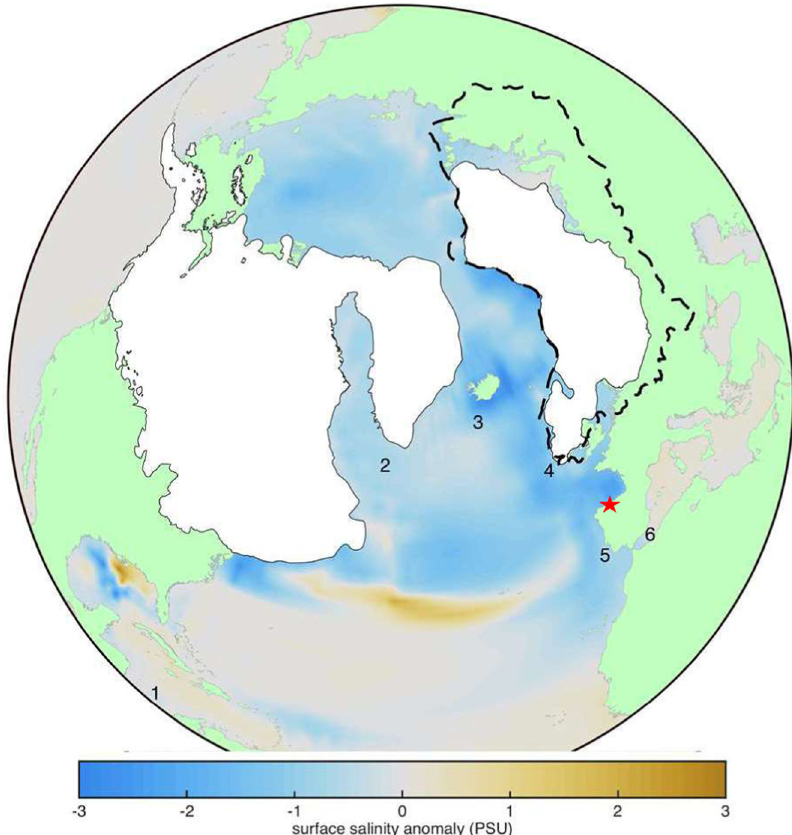
Fig. 1 Northern hemisphere ice sheets and site locations. The distribution of North American Ice Sheet (NAIS) and Eurasian Ice Sheet (EIS) during the LGM (white coverage, after 108 ) and the maximum extent of EIS glacial deposits prior to the last glacial cycle (black dashed lines, after 46 ). Color scale over the ocean depicts the distribution of marine salinity anomalies at 16 ka resulting from a 3000 ky simulation with meltwater derived 45% from the EIS and 55% from the NAIS delivered to appropriate coastal outlets and leading to a 20% AMOC slowdown 10 . NW Iberian cave site (red star), and locations discussed: 1 Western Caribbean Site (ODP 999); 2 Eirik drift (MD03-2664); 3 North Atlantic Sites (ODP 983 and 984); 4 Irish Margin site (MD01-2461); 5 W Iberian Margin MD99-2334K; MD01-2343; MD01-2444; MD95-2042, MD95-2040; SHAK06-5K); 6 S Iberian Margin (ODP 976 and 977;